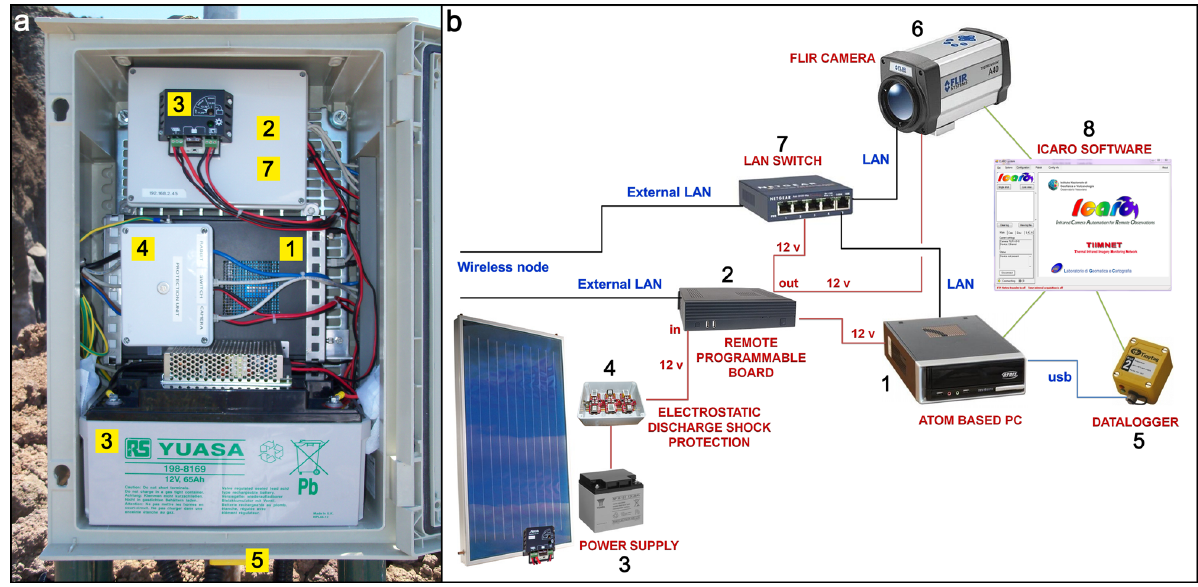
Figure 2. ICARO Remote Monitoring Station at Vesuvius (a) and the related logical scheme